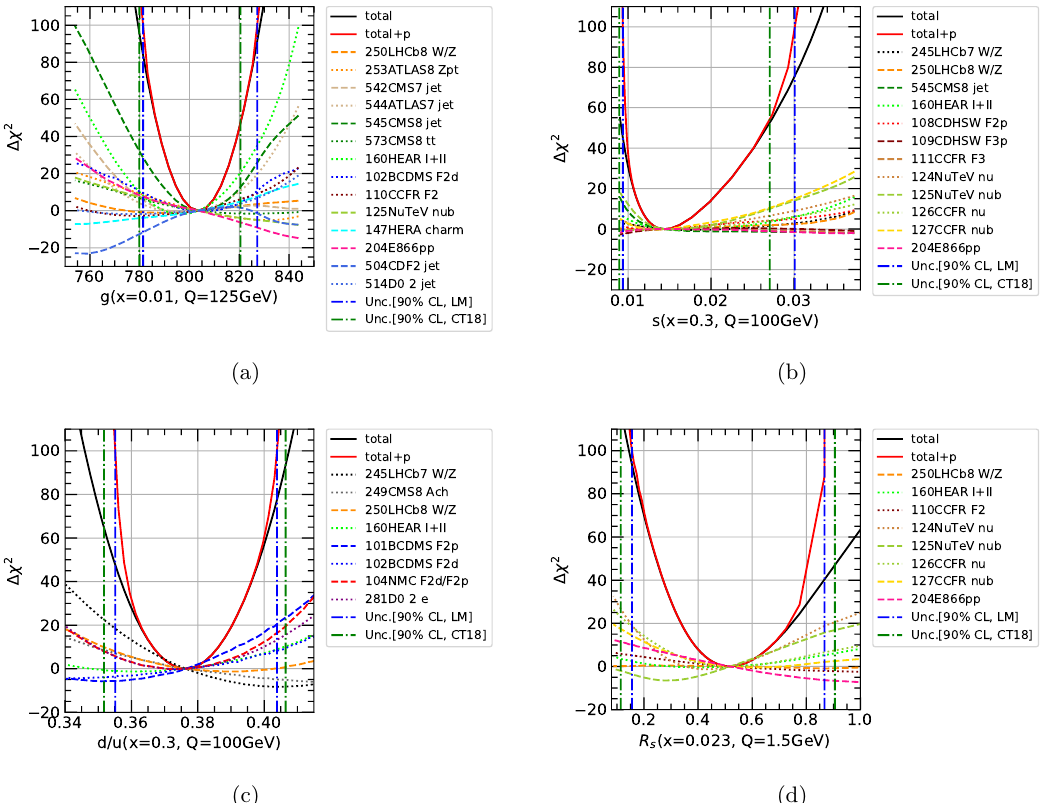
Figure 7 . LM scans on the g ( x = 0 . 01 GeV, Q = 125 GeV), s ( x = 0 . 3 , Q = 100 GeV), d/u ( x = 0 . 3 , Q = 100 GeV) and R s ( x = 0 . 023 , Q = 1 . 5 GeV). The black and the red solid lines represent ∆ χ 2 and ∆ χ 2 + P respectively. The dot and the dash lines indicate the contributions to ∆ χ 2 from individual data sets. The blue and the green vertical dot-dash lines indicate the uncertainties at 90% CL determined with the LM method by requiring ∆ χ 2 + P = 100 and with the Hessian method from the published CT18 NNLO PDFs,